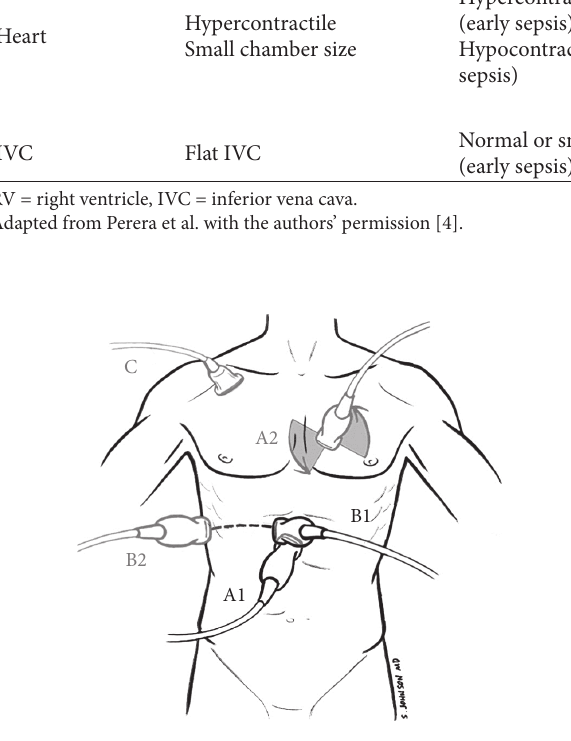
Figure 1: Prerenal assessment: cardiac contractility and intravascu- lar volume. A1 = subcostal cardiac view (curvilinear or phased-array probe), A2 = parasternal long- and short-axis views (phased-array), B1 = IVC long-axis view (curvilinear or phased-array), B2 = IVC long-axis from midaxillary line view (curvilinear or phased-array), and C = subclavian vein view (high-frequency linear probe) [25].